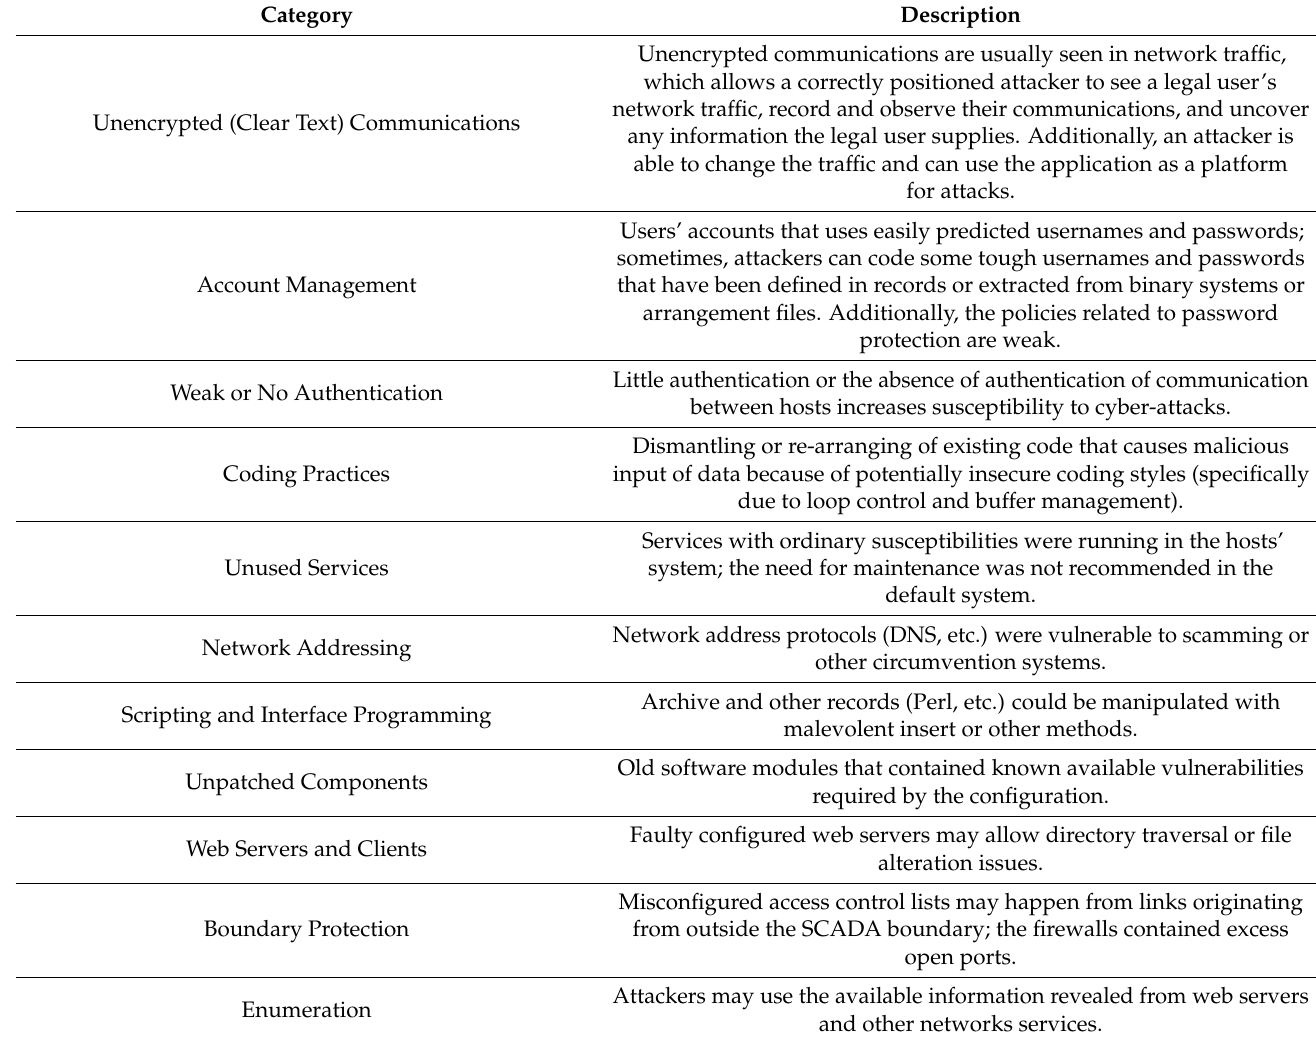
Table 1. The vulnerabilities detected from the NSTB assessment